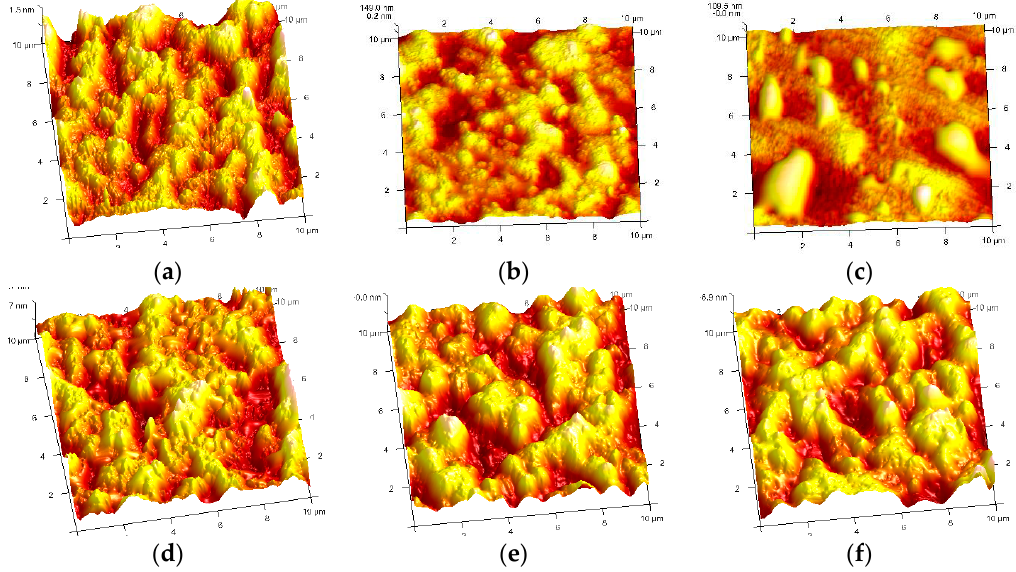
Figure 3. AFM image of PE films after different DBD plasma treatments ( a : pristine PE, Ra 30nm; b : Ar plasma, Ra 34.5 nm; c : O 2 plasma, Ra 24.5 nm; d : Ar+allylamine plasma, Ra 30.9 nm; e : Ar+acrylic acid, Ra 37.2 nm; and f : Ar+ethanol, Ra 38.8 nm).